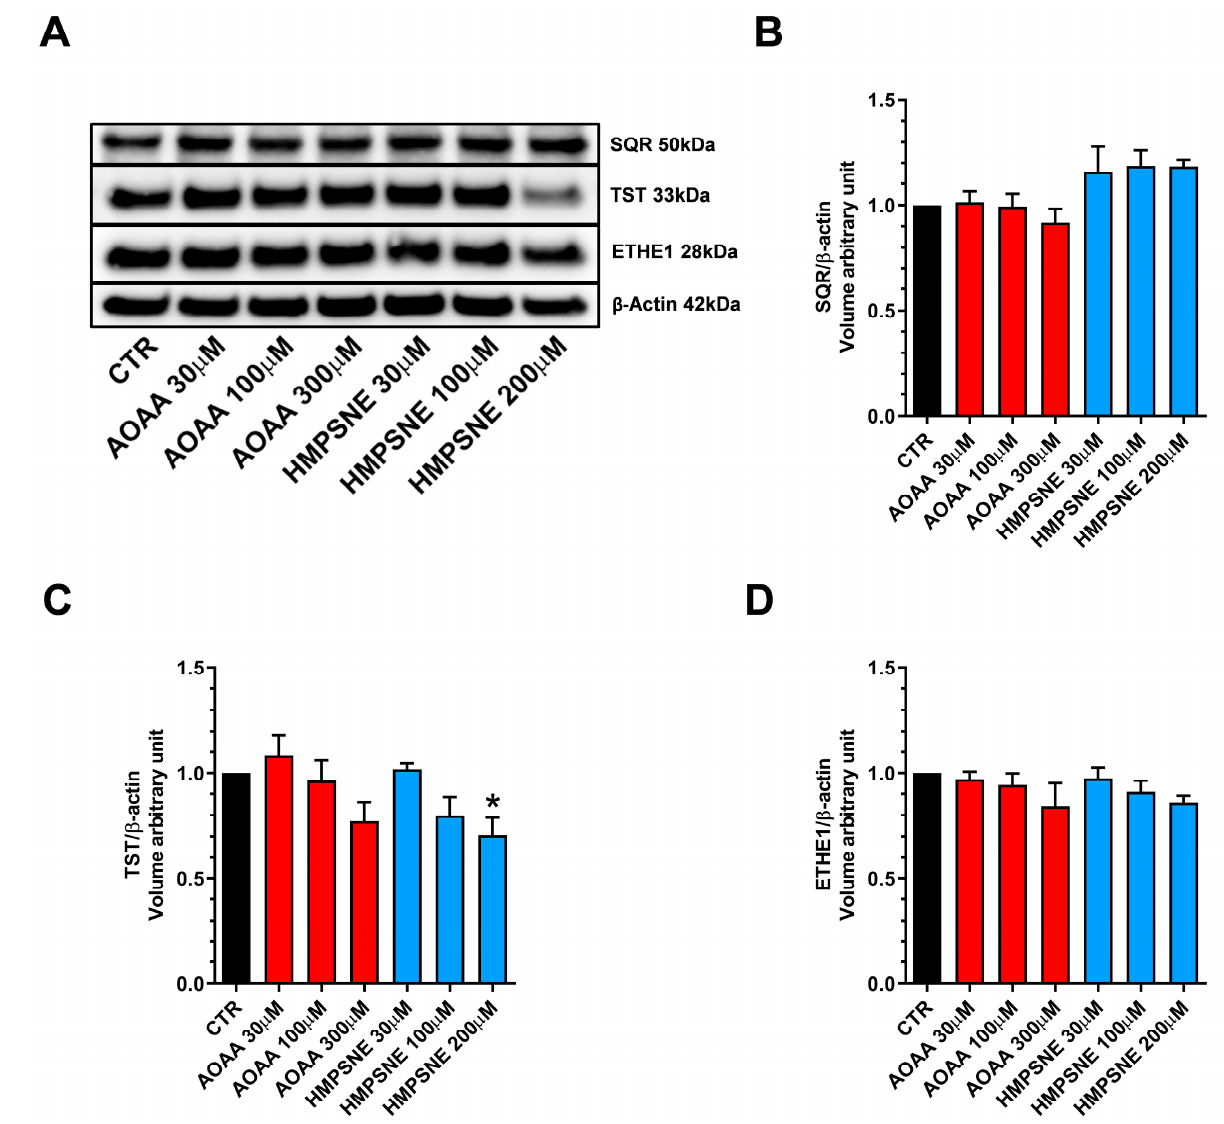
Figure 4. H 2 S-catabolizing enzyme expression in EO771 cells; effect of CBS/CSE or 3-MST inhibition. SQR, TST and ETHE-1 expression was analyzed by Western blotting ( A ) and densitometry analysis ( B – D ); in the absence or presence of 48 h of AOAA or HMPSNE treatment. N = 4 independent experiments ± SEM. * p < 0.05 indicates significant inhibition of TST expression by HMPSNE.